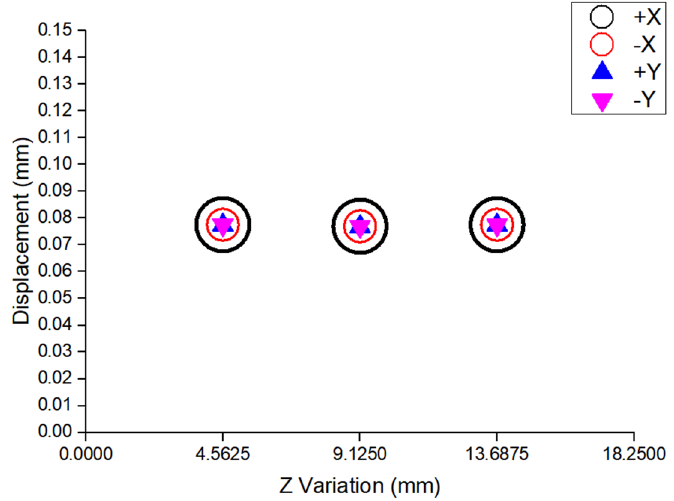
Figure 12. Deformation value of each quadrant point in different height positions for axial symmetry heat transfer.